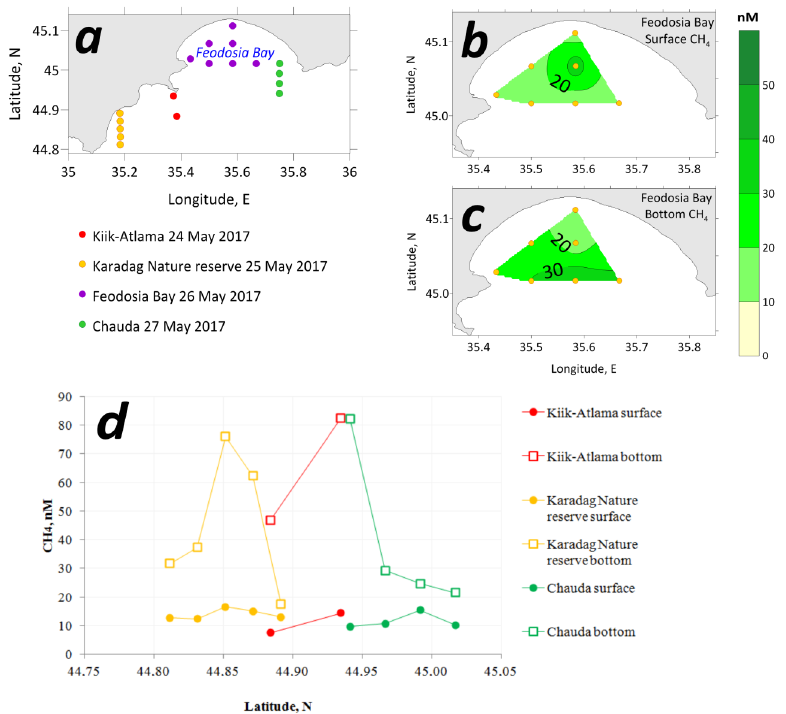
Figure 12. Location of water sampling stations in Feodosia Bay area, May 2017 ( a ). Methane content in the surface ( b ) and bottom ( c ) waters in the bay and on the sections to the south of the bay ( d ).